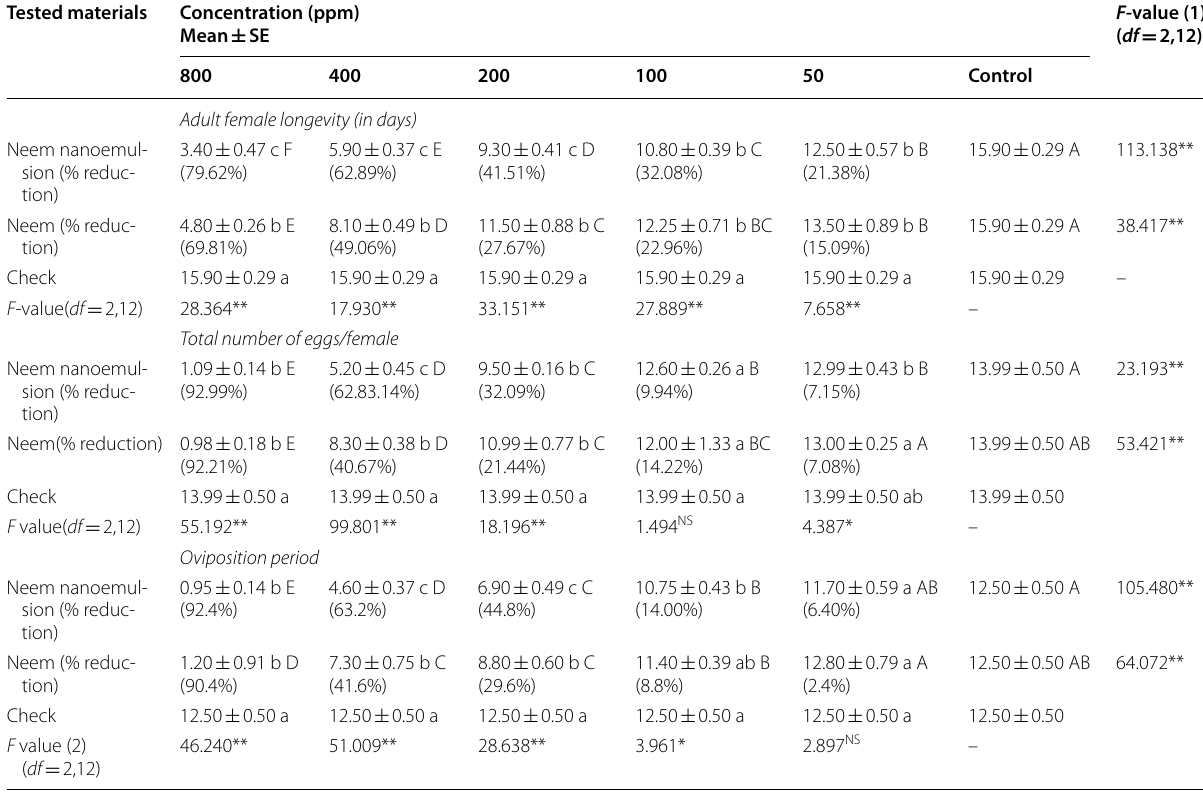
Means in a single column followed with the same small letters are not significantly different ( P Means in a single row followed with the same capital letters are not significantly different ( P